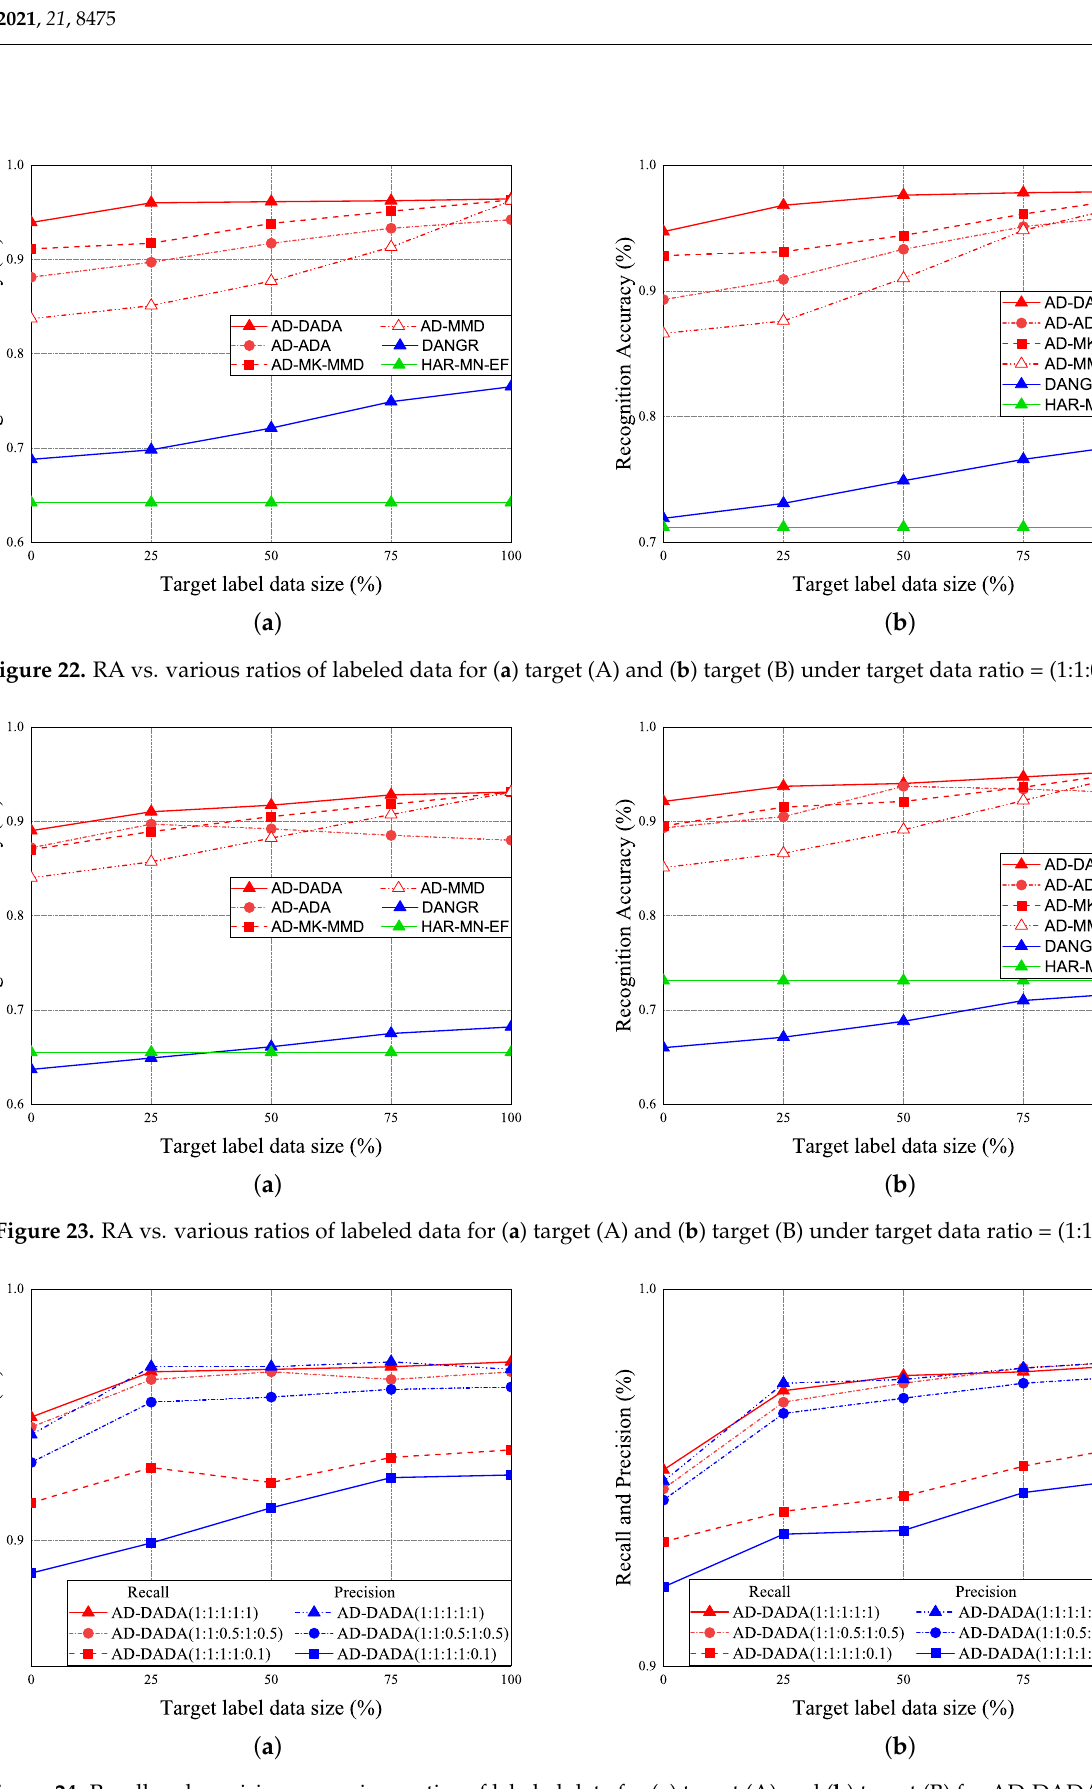
Figure 24. Recall and precision vs. various ratios of labeled data for ( a ) target (A) and ( b ) target (B) for AD-DADA